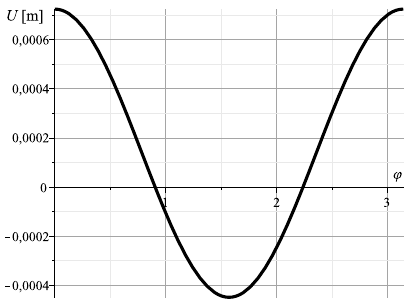
Figure 10: Plot of M ( φ ) (Example 5.1).